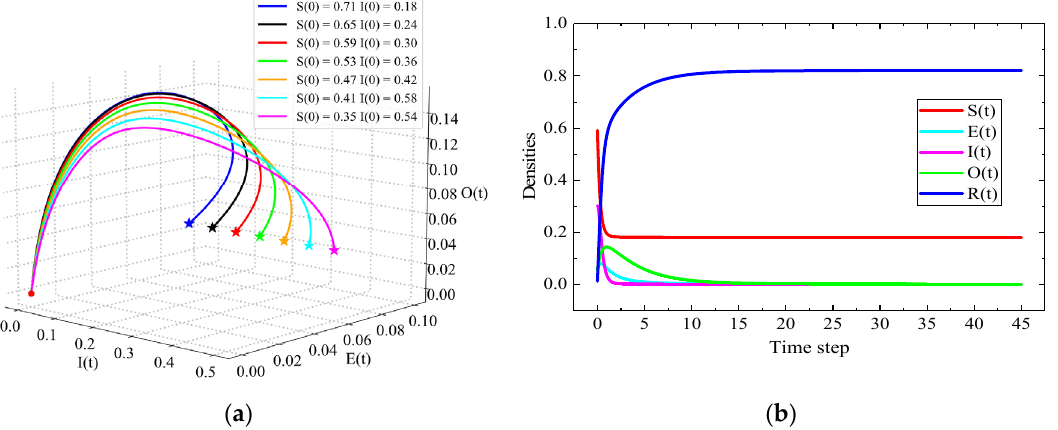
Figure 5. ( a ) The changes of spreaders, hesitators and rumor debunkers when the initial densities of ignorant people and spreaders are randomly given in 7 groups (The star symbols represent the initial values of densities of each type of individual, the dot represents the steady-state value of rumor propagation.); ( b ) density evolution curves of each type of individual when S (0) = 0.59, E (0) = 0.05, I (0) = 0.3, O (0) = 0.05, and R (0) = 0.01.